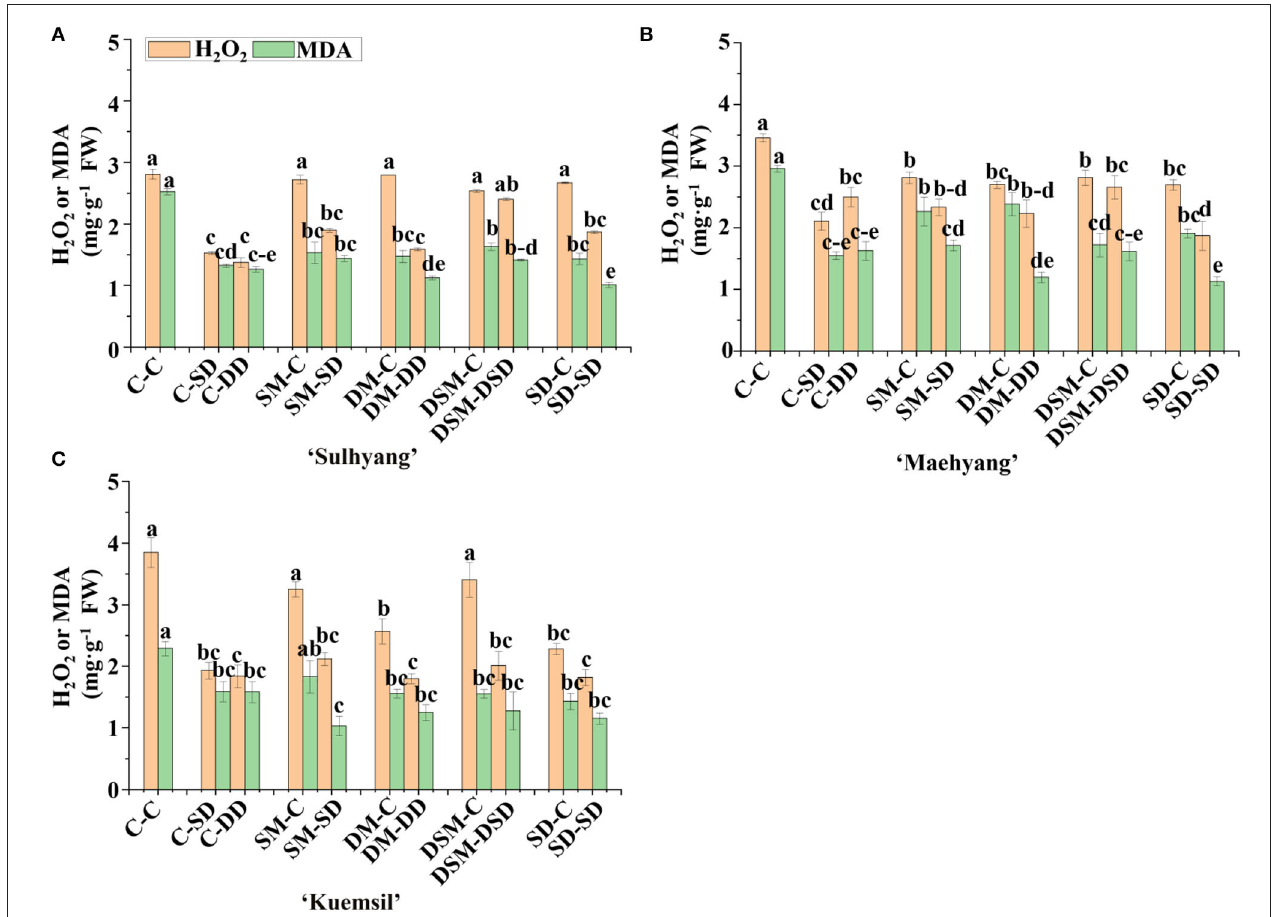
FIGURE 10 | The H 2 O 2 and MDA contents in leaves of strawberry transplants (A) “Sulhyang”; (B) “Maehyang”; and (C) “Kuemsil” as affected by the Si treatment after subjection to 43 ◦ C for 7 days. Lowercase letters indicate significant differences calculated by the Duncan’s multiple range test at p ≤ 0.05. See Figure 1 for descriptions of treatment